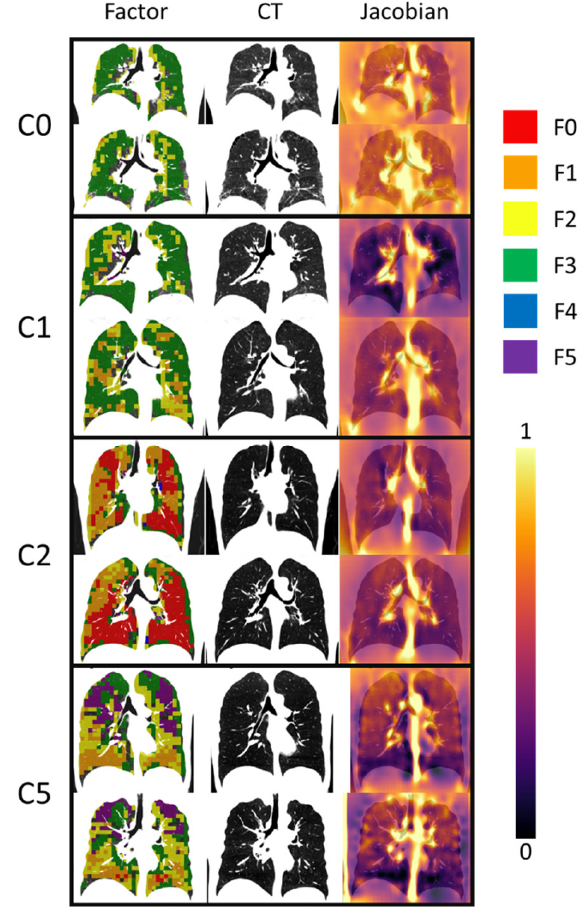
Figure 3. Comparison of two representative subjects each for C0, C1, C2, and C5. Factor masks (left column) and Jacobian masks (right column) were overlapped with CT images (middle column).